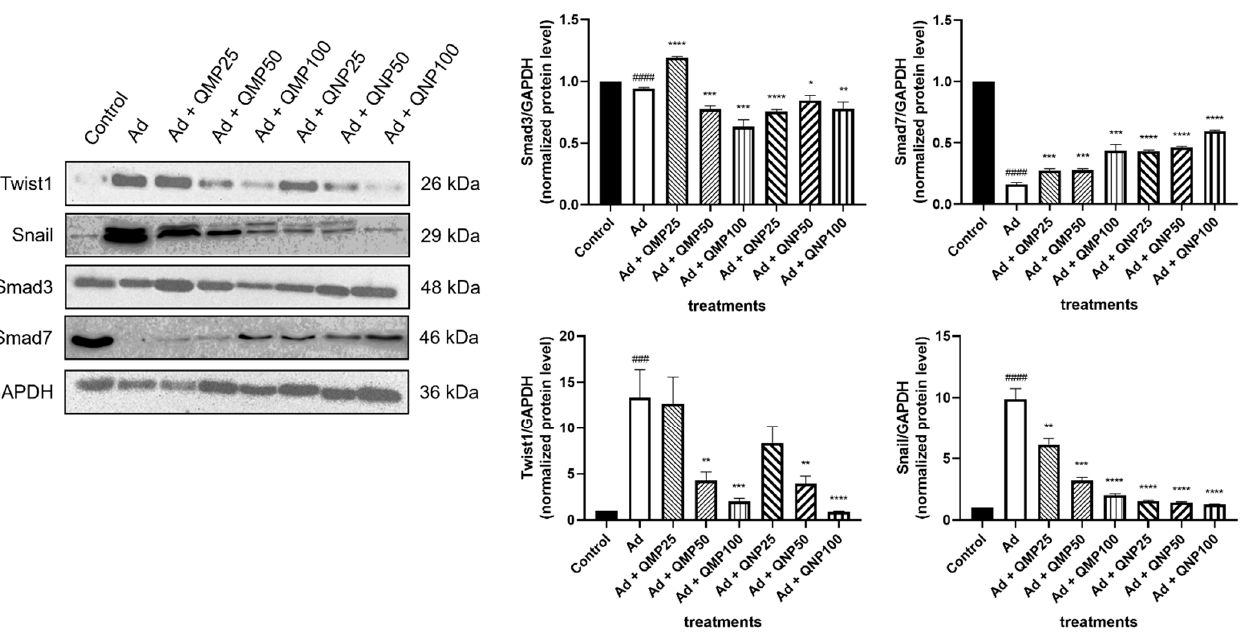
Figure 8. Effect of quercetin macroparticles and nanoparticles on the expression of key proteins involved in the EMT process and the TGF- β /Smad signaling pathway. Expression levels of proteins were determined by Western blotting. Twist1 and Snail decrease their expression in the groups treated with QMPs and especially in the groups treated with QNPs in a dose-dependent manner, while Smad7 increases its expression in the higher dose of QMPs and in all doses of QNPs. EMT: Epithelial–Mesenchymal Transition. Mean ± SD ( n = 3); ### p < 0.001, #### p < 0.0001 compared to the Control group; * p < 0.05, ** p < 0.01, *** p < 0.001, **** p < 0.0001 compared to the Ad group.